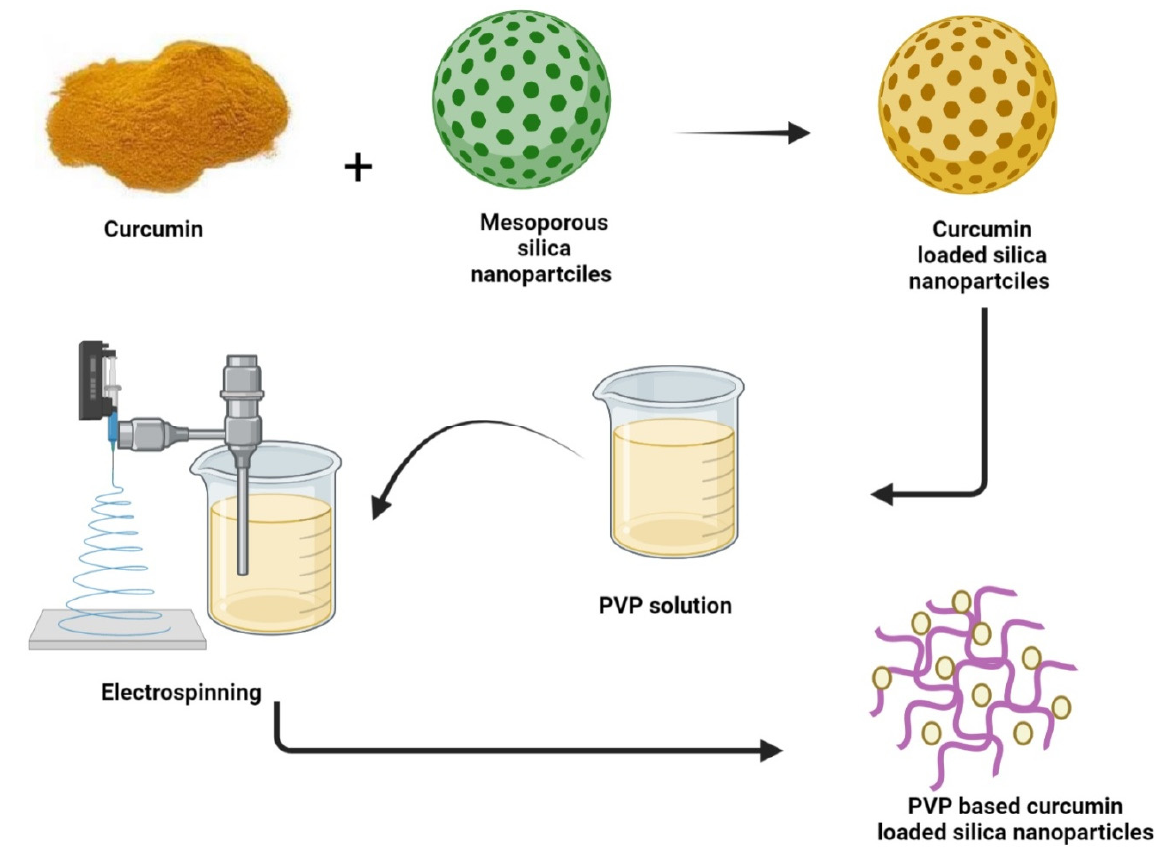
Figure 1. Fabrication of curcumin ‐ loaded PVP based silica mesoporous nanofibers mat.